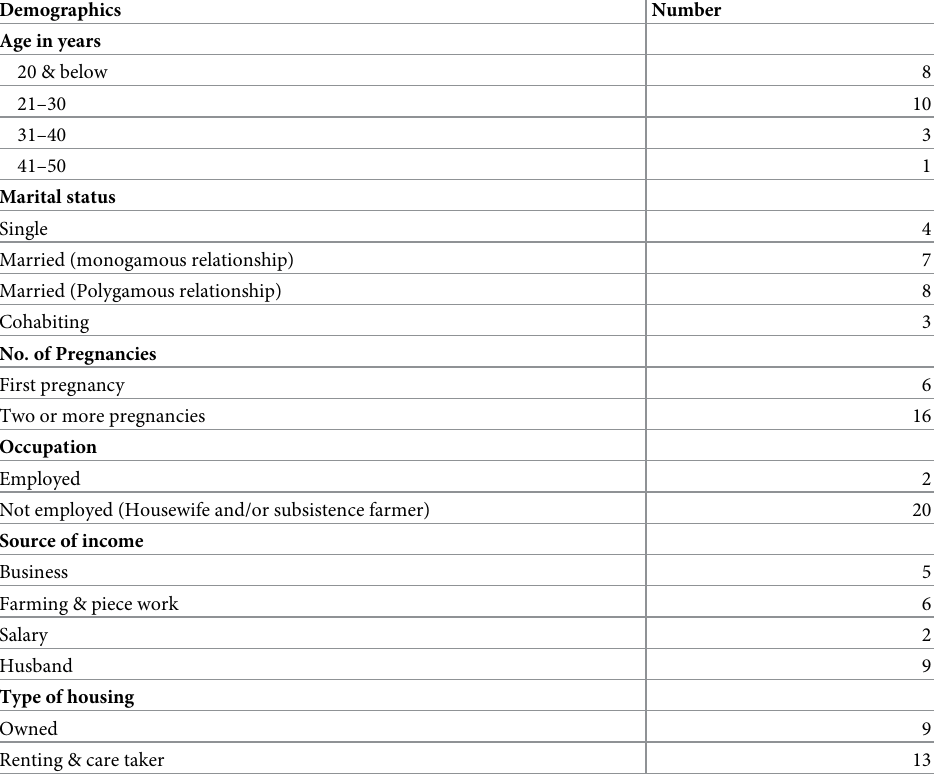
Table 3. Sample description of perinatal women screened positive on EPDS (n =